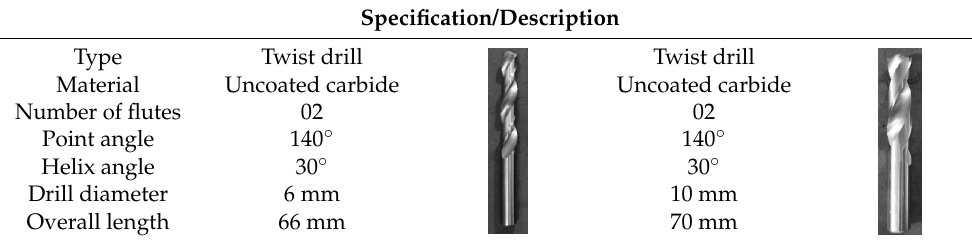
Table 2. Details of drill bits.